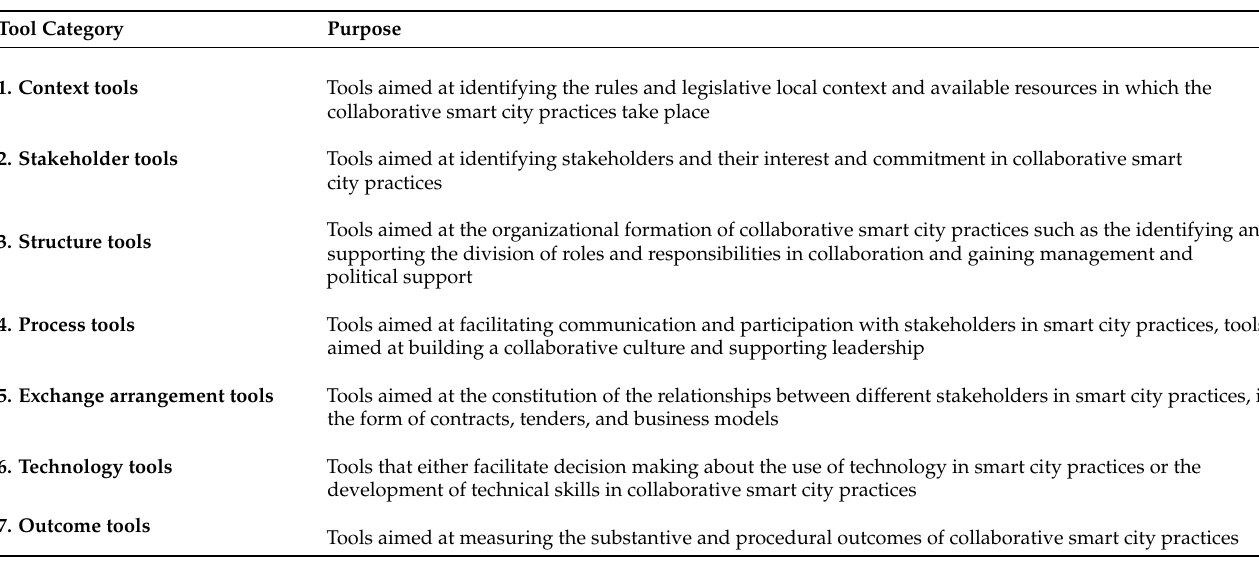
Table 3. Seven categories of smart governance